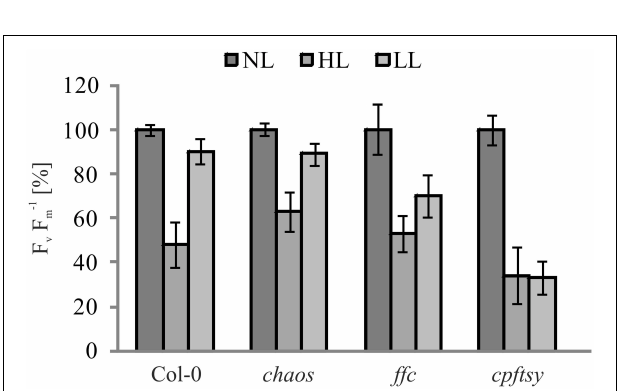
FIGURE 2 | Maximum quantum efficiency of PS II in cpSRP mutants. The maximum quantum efficiency of PS II (F v F − 1 m ) was determined in wild type and mutant plants in the rosette stage after dark adaption. Prior to the measurements, plants were raised under normal light conditions (NL, 120 µ mol photons m − 2 s − 1 ), then exposed to high light for 180min (HL, 1000 µ mol photons m − 2 s − 1 ) with a following regeneration at low light for 90min (LL, 50 µ mol photons m − 2 s − 1 ). For each plant, F v F − 1 m values at NL were adjusted to 100%. The error bars show the standard deviation ( n = 10 ).